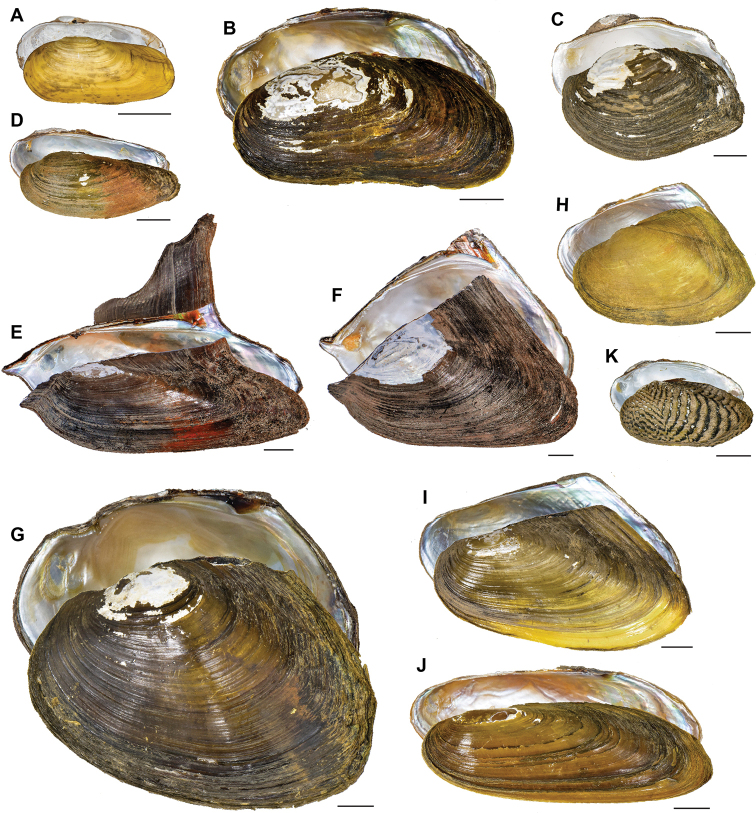
Freshwater bivalves of the Tonle Sap basin, Cambodia (Pharidae and Unionidae) ANovaculina
siamensisBBineurus
mouhotiiCContradens
contradensDEnsidens
ingallsianusEHyriopsis
bialataFHyriopsis
delaporteiGMonodontina
cambodjensisHPhysunio
micropterusIPilsbryoconcha
linguaeformisJPilsbryoconcha
lemeslei and KScabies
mandarinus. Scale bars: 10 mm, unless stated otherwise. Photographs by K Macharoenboon.